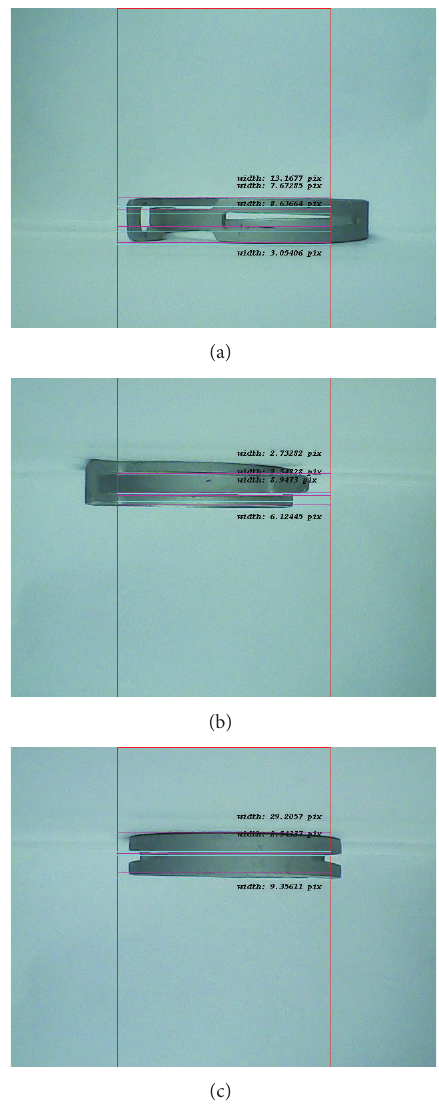
Figure 6: The height calculation diagrams of the three lateral